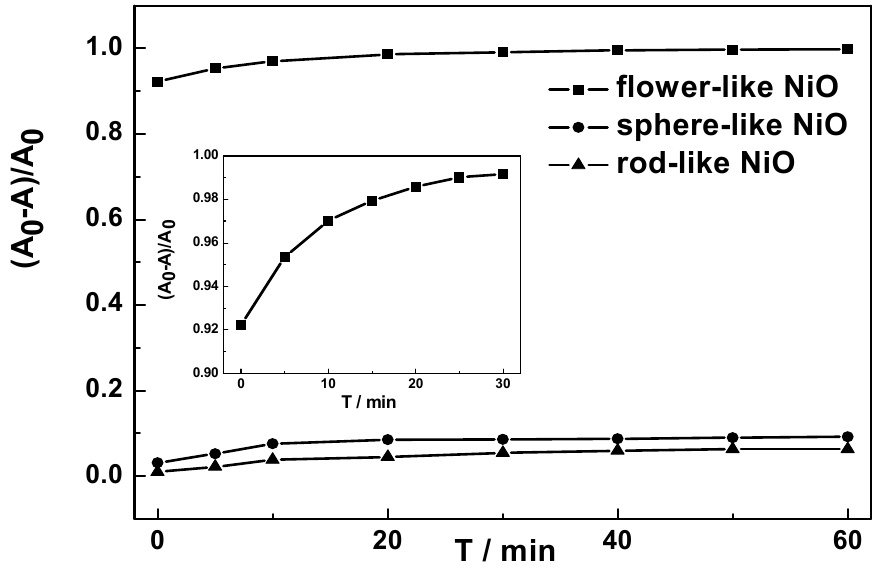
Figure 8. Degradation rates of MO at different intervals in the presence of NiO samples with different morphologies. The inset is the local magnification pattern of degradation curve in the presence of flower-like NiO.